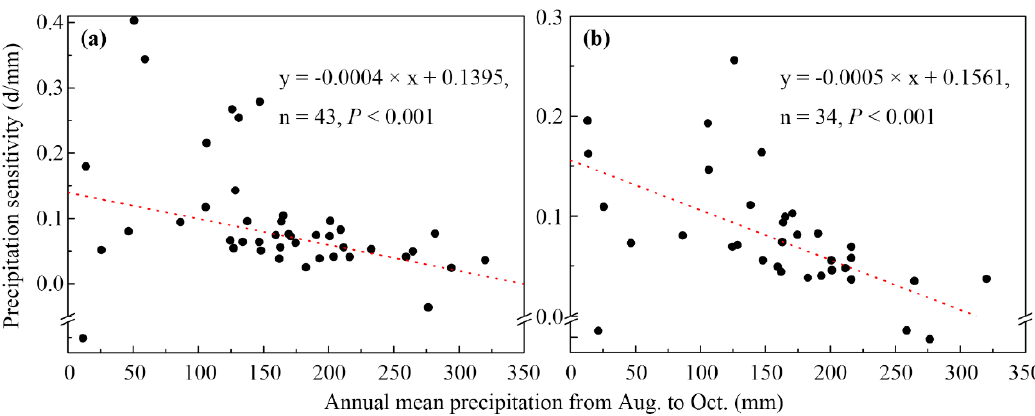
Figure 6. Regression analyses between annual mean precipitation from August to October and sensitivity of MSD to preseason precipitation at the 91 meteorological stations. ( a ) NDVI-derived MSD, ( b ) EVI2-derived MSD. The red dashed line is the Theil–Sen linear trend tested using the Mann–Kendall significance test.